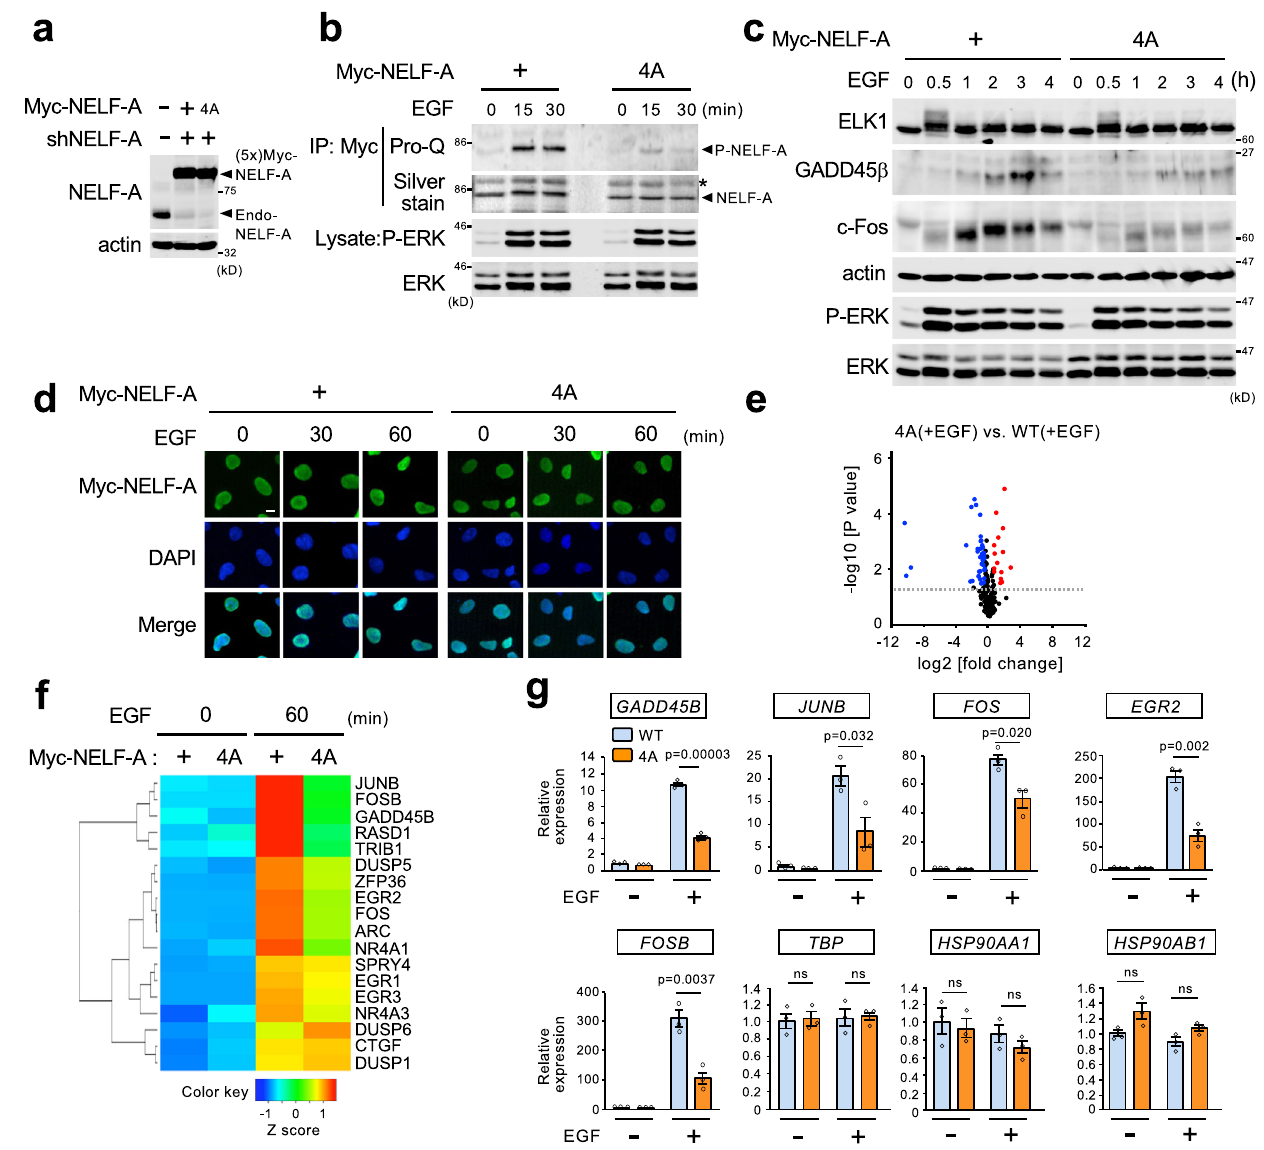
Fig. 3 | ERK-mediated NELF-A phosphorylation promotes the expression of IEGs. a HEK293 cells stably expressing shRNA-resistant Myc-NELF-A (WT or 4A) were depleted of endogenous NELF-A using shRNA. Levels of the Myc-NELF-A proteins were con fi rmed by immunoblotting. Actin, loading control. b – d HEK293- WT and − 4A cells were stimulated with EGF (20ng/ml). In ( b ),Myc-NELF-A or Myc- NELF-A(4A) immunoprecipitates were assessed for phosphorylation using Pro-Q diamond gel staining (top). Total Myc-NELF-A was visualized with silver-stain (second). In ( c ), ELK1, GADD45 β , and c-Fos levels were monitored by immuno- blotting.Up-shiftedbandsofELK1indicatephosphorylation.Actin,loadingcontrol. In( b , c ),lysateswereimmunoblottedforphospho-andtotalERK1/2(lowerpanels). In ( d ), subcellular localization of Myc-NELF-A or Myc-NELF-A(4A) was detected by immuno fl uorescentstainingwithanti-Mycantibody(green).DAPI,nuclearstaining.